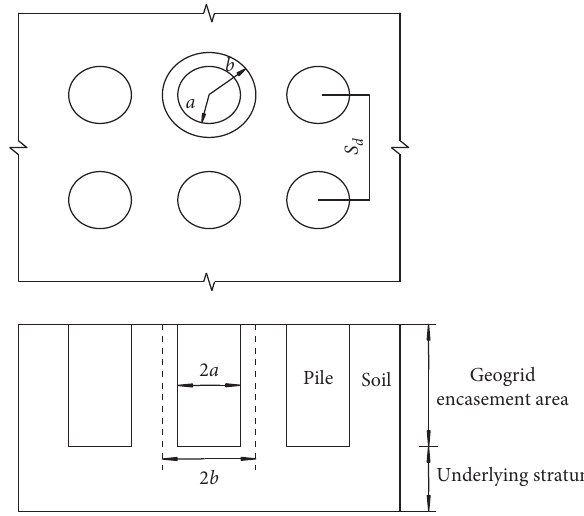
Figure 2: The unit of pile and soil.